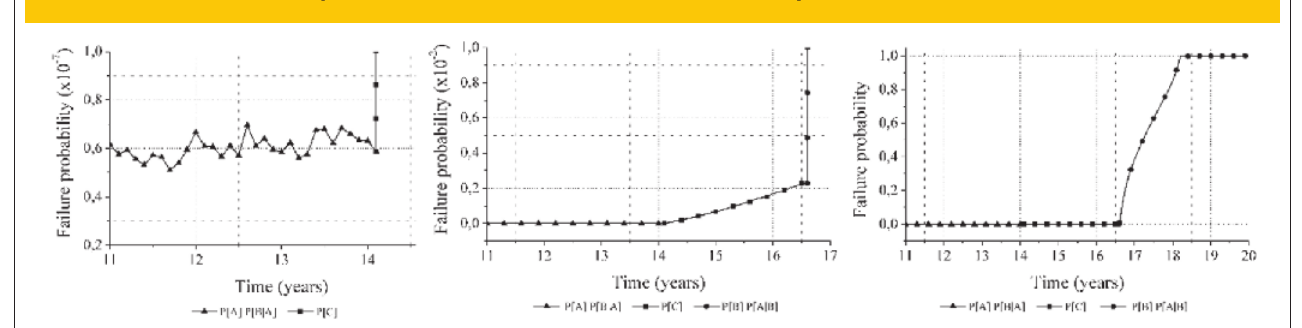
Figure 10 – Evolution of the probability of failure considering only the most probable failure path. Penalization of the reinforcement yield stress